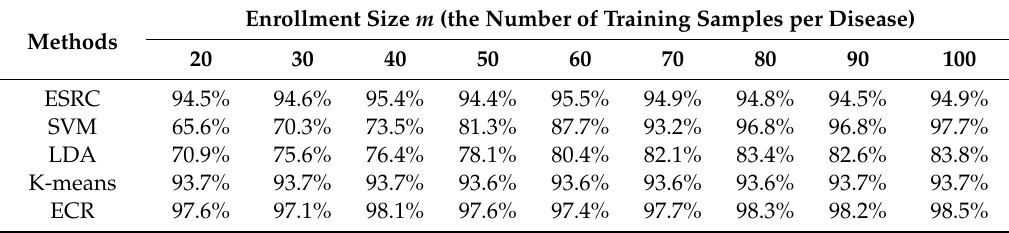
Table 6. Disease recognition accuracies when di ff erent enrollment size is adopted.